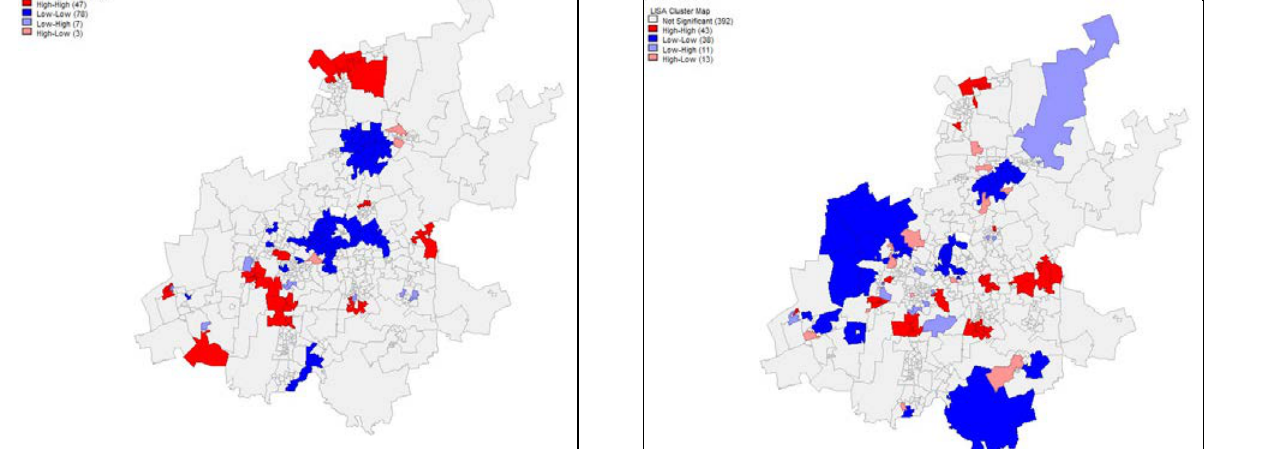
Figure 10. Cluster map of intensity of poverty (%) in